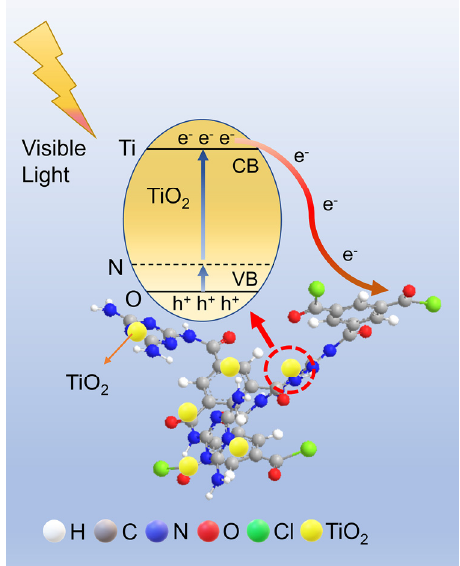
Figure 10. Photocatalytic mechanism of photo-generated carrier separation and transfer on TMP–TiO 2 sample under visible